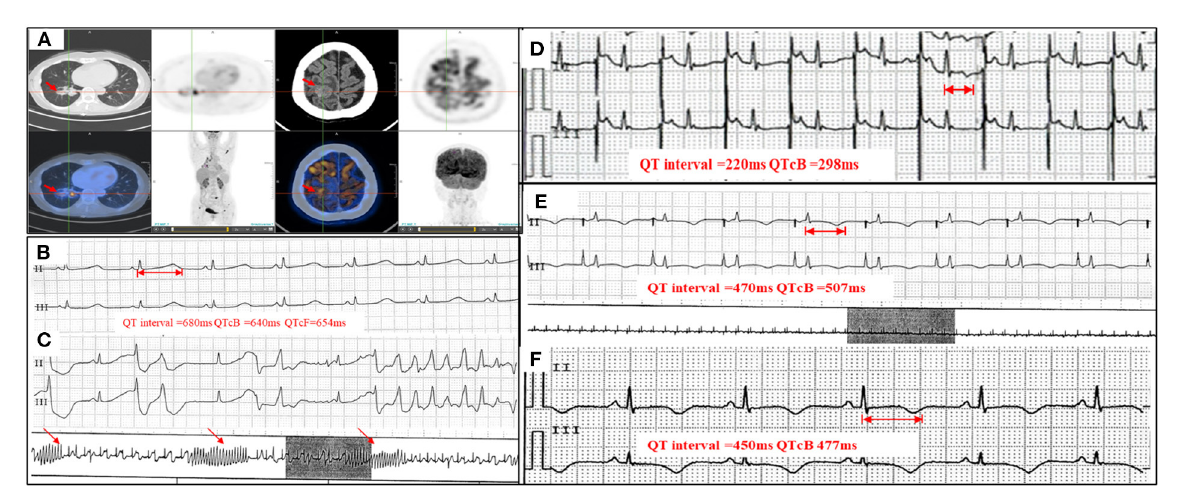
FIGURE1 PET-CT, serial Holter monitoring, and ECG. (A) PET-CT showing peripheral pulmonary carcinoma and brain metastasis (arrowheads); (B) Holter monitoring on admission showing prolonged QTc interval (QTcB 640ms); (C) Holter monitoring on admission showing frequent VTs and TdP (arrowheads); (D) ECG with a temporary pacemaker and overdrive pacing at 110 bpm (QTcB 298ms); (E) Holter monitoring with a temporary pacemaker and pacing at 70 bpm (QTcB 507ms); (F) ECG at discharge showing near-normal QTc interval (QTcB 477ms). VT, ventricular tachycardia; TdP, torsade de pointes; QTcB, QTc interval calculated with Bazett formula; PET-CT, positron emission tomography – computed tomography; ECG,